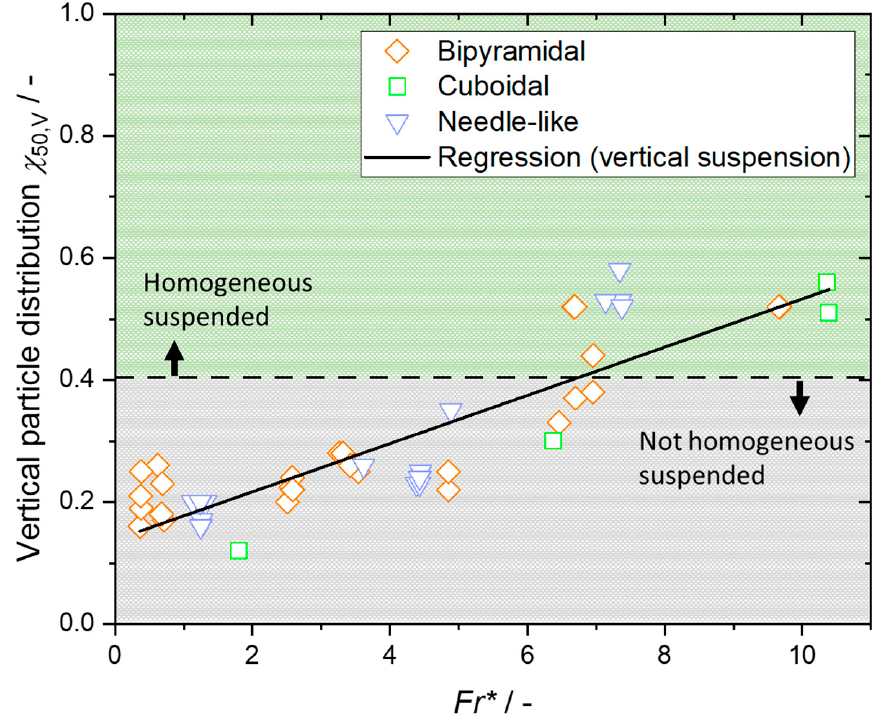
Figure 7. Plot of the vertical particle distribution represented by χ 50,V over the modified Froude number Fr ∗ . The used data are given in the Supporting Information in Tables S1 and S2.